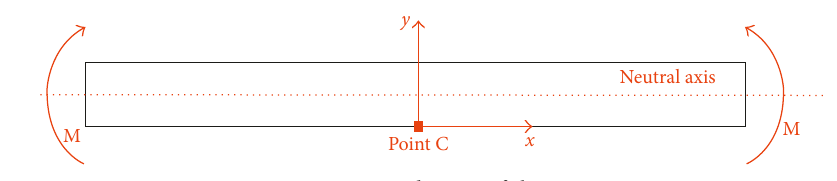
Figure 2: Fatigue damage of the point C.